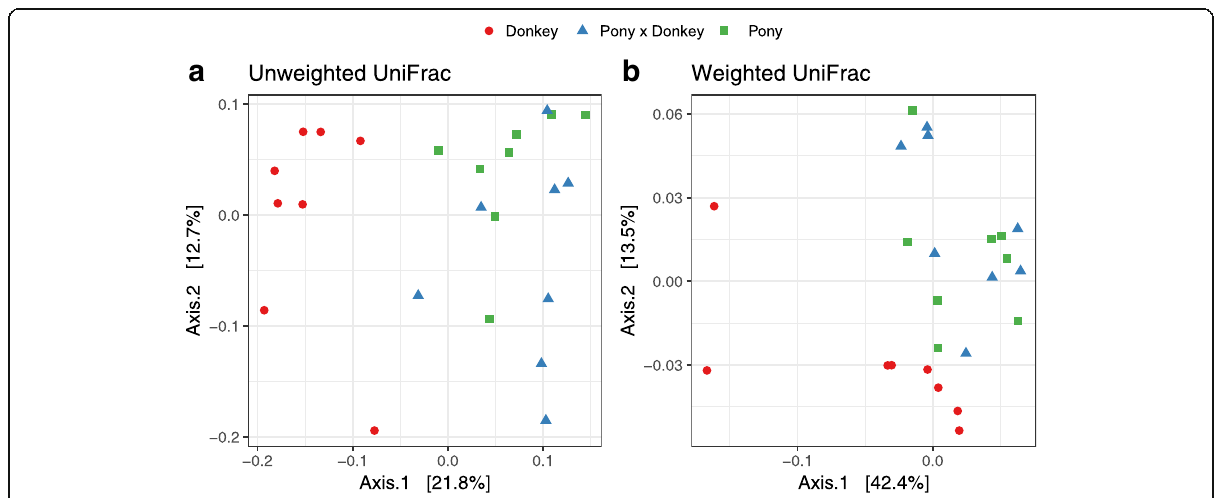
Fig. 1 Unweighted ( a ) and weighted ( b ) UniFrac based principal co-ordinates analysis of the fecal prokaryotic community composition of the different equine types at the OTU level. Analysis used Log 10 transformed data, and the percentage values given on each axis indicate the amount of total variation